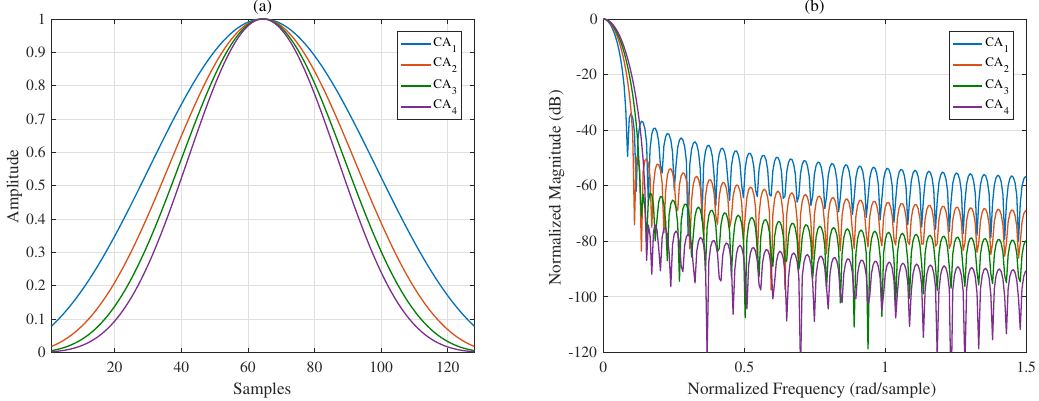
Figure 1. Windows with different MWs and PSLs ( a ) in the time domain and ( b ) in the frequency domain.